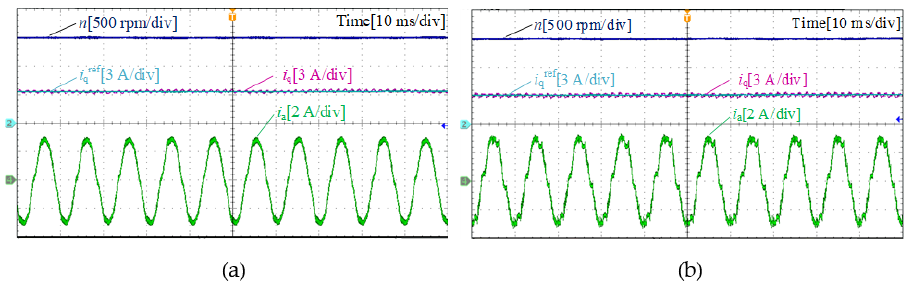
Figure 5. Steady-state experimental waveforms. ( a ) Proposed MPDSC. ( b ) Double-vector PDSC.